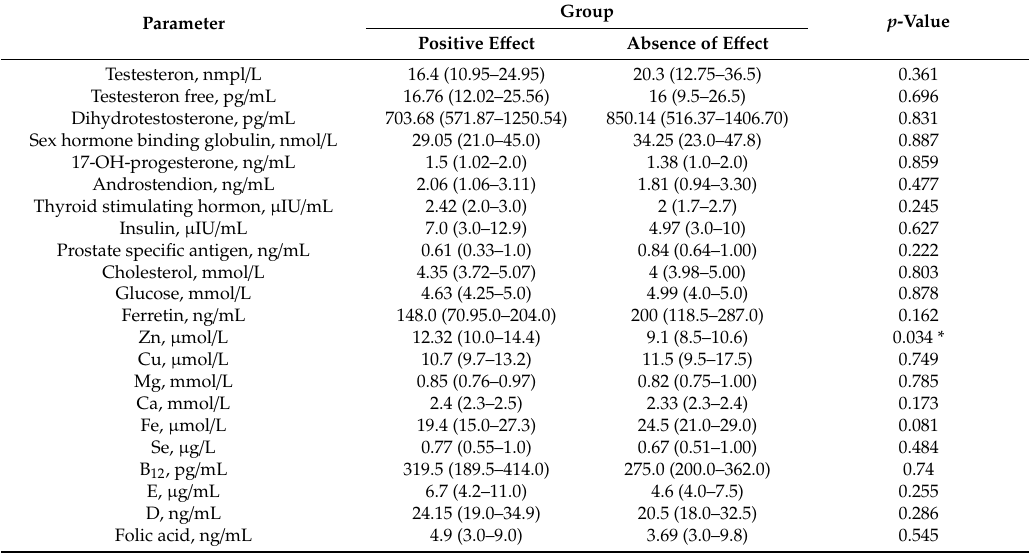
Table 2. Baseline serum biochemical and micronutrient parameters in patients showed a di ff erent response to conservative